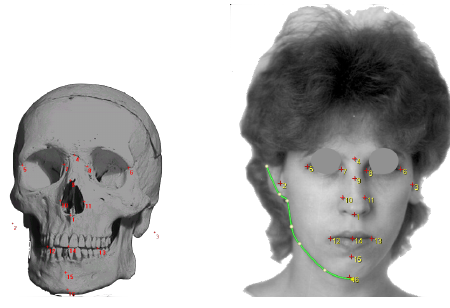
Figure 1. Craniometric and cephalometric landmarks The analysis performed in (Damas et al., 2011) allowed to indi- cate as the key problem of reliable craniofacial superimposition the orientation problem: to find ”the size and orientation of the skull to correctly match the head in the photo”. This problem is essentially photogrammetric one, but the photogrammetric ap- proach did not widely used in a practice as a basis for the problem solution. Most part of techniques use directly acquired a skull photo and then aligning it with a given face photograph using commercial (e.g. Adobe Photoshop) or original software (Scully and Nambiar, 2002), (Ghosh and Sinha, 2005). In fact, it would be most of the times impossible to obtain the technical specifica- tions used to take the antemortem